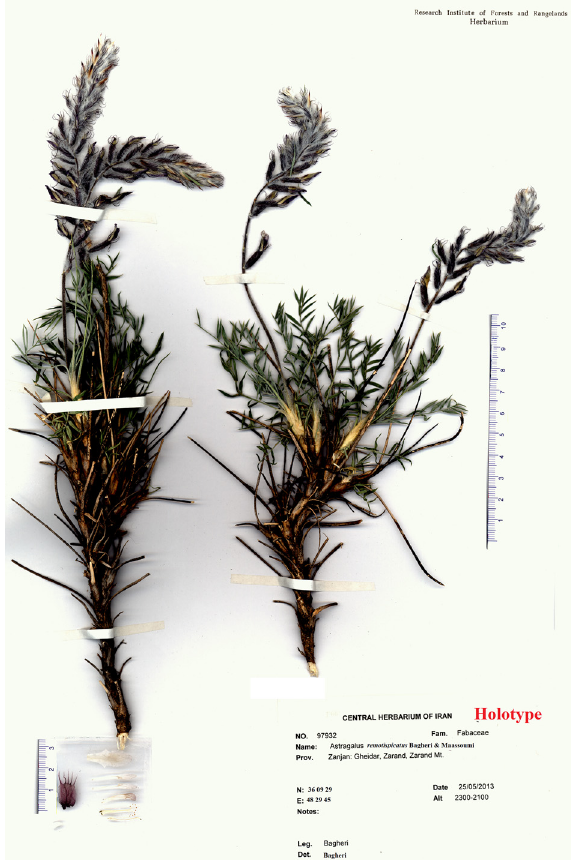
Fig 5. Holotype of Astragalus remotispicatus (Bagheri 97932).